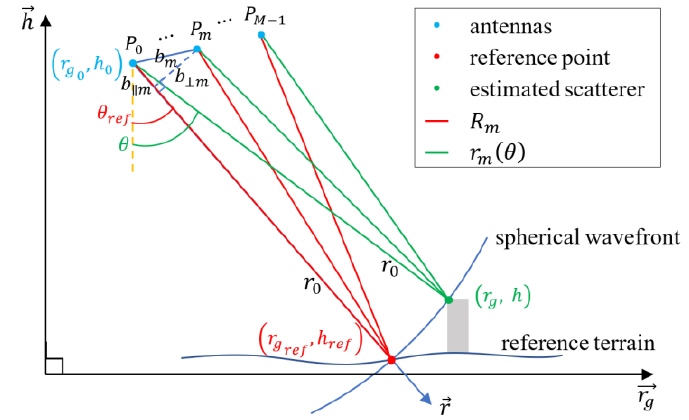
Figure 4. TomoSAR imaging geometry based on a spherical wavefront geometry.